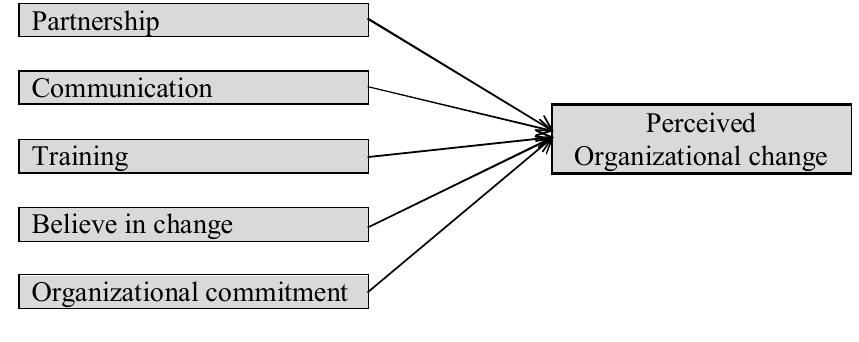
Fig. 1. The proposed study